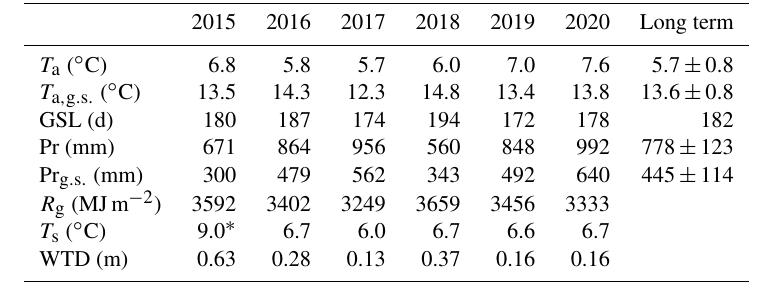
∗ T s was calculated for 3 July–31 December 2015. Table 2. Mean air temperature in the winters (1 November–31 March) of 2015–2020 and the mean long-term value of air temperature at meteorological station Toropets ( ◦ C), with the standard deviation ( ±